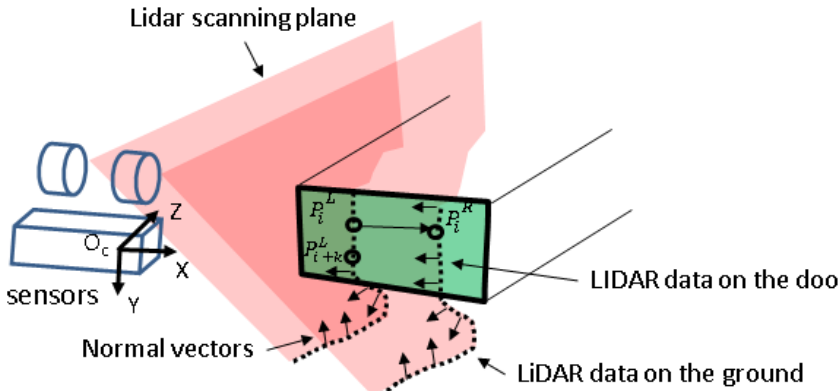
Figure 8. A method to detect the door of a dump truck cargo box using two LIDAR sensors. The points on the plane have the same normal vector, and the dot product with the camera z-axis is close to − 1. The normal vector is computed with two LIDAR point clouds.